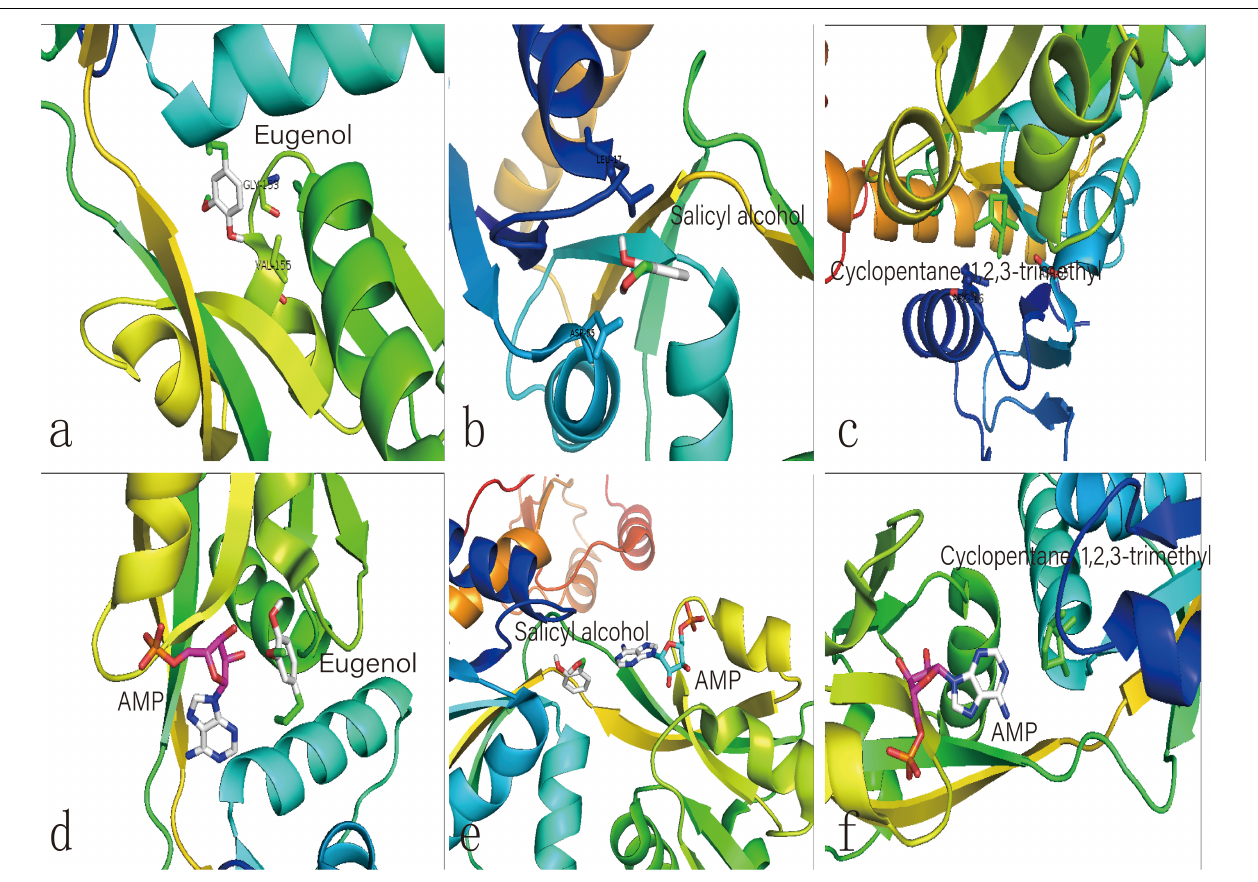
FIGURE 6 | Molecular docking analysis of HisG protein. (a–c) illustrate the interaction of eugenol, salicyl alcohol, and 1,2,3-trimethylcyclopentane with the activity site of the HisG protein; Comparison between AMP and eugenol (d) , salicyl alcohol (e) , and cyclopentane (f) in the HisG protein activity